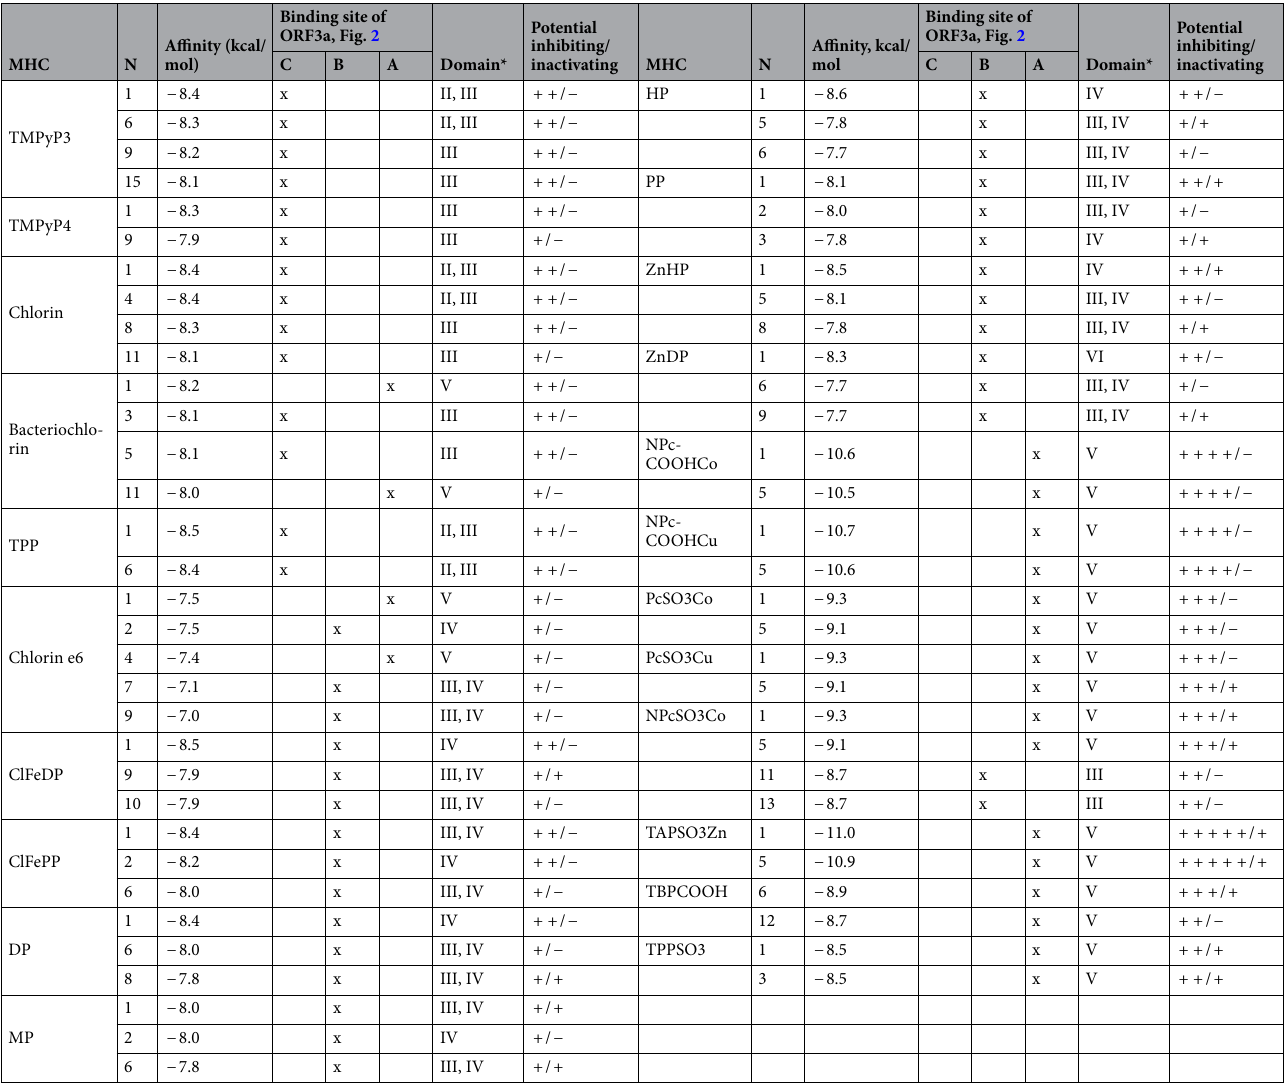
Table 1. Molecular docking parameters of macroheterocycles with ORF3a. *The domain structure is indicated in accordance with the reference 22